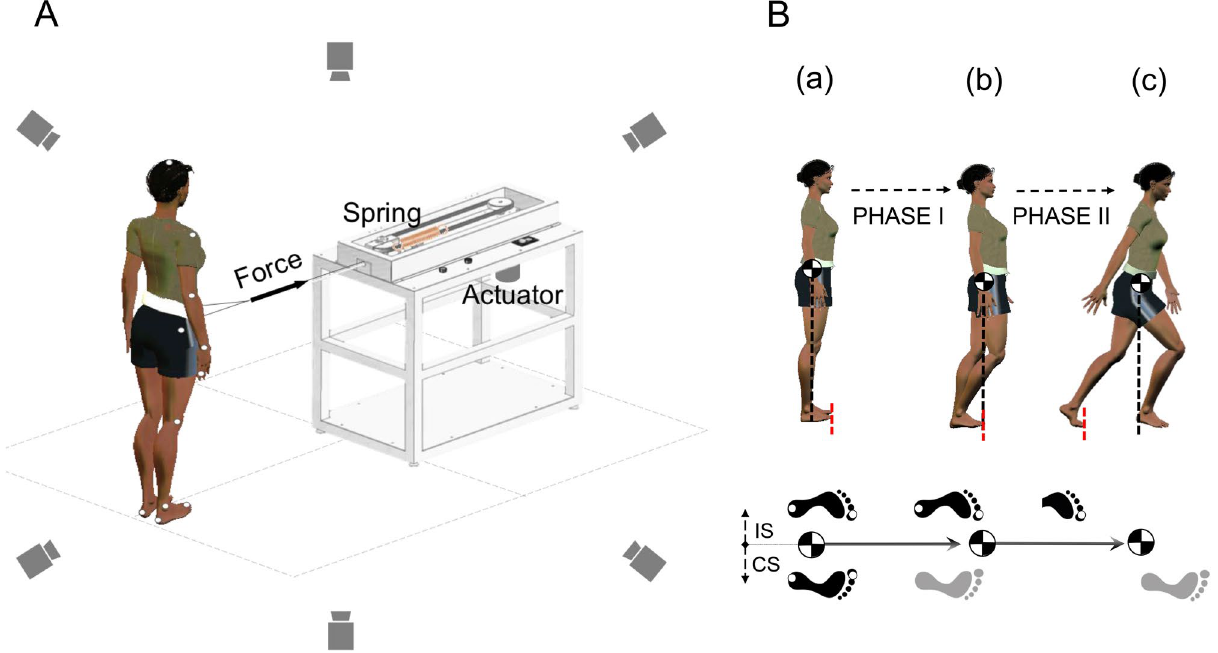
Figure 1. Schematic representation of experimental settings with a waist-pull apparatus and six infrared cameras. Perturbation of standing posture was provided in the anterior direction by pulling a cable connected to the subject’s belt ( A ). The stepping movement was analyzed in two phases ( B ): Phase I was defined as the period from perturbation onset (a) to the time when the x CoM passed outside of the BoS of the contralateral side (CS), shown in black (b). Phase II was defined as the time from (b) to foot–ground contact of ipsilateral side (IS), shown in gray (c). Drawn using Adobe Illustrator CS6 (www.adobe .com) and Microsoft Office 2016 (www. micro